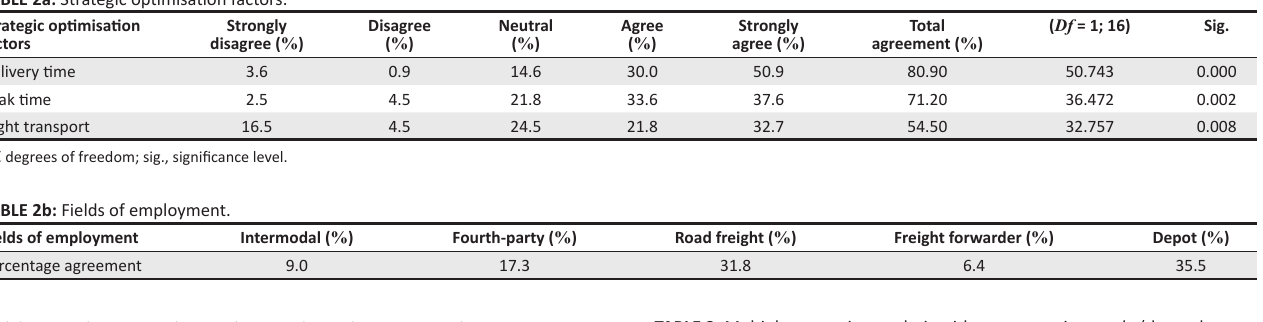
TABLE 3: Multiple regression analysis with transportation mode (dependent variable). Regression results: Dependent variable – Transportation